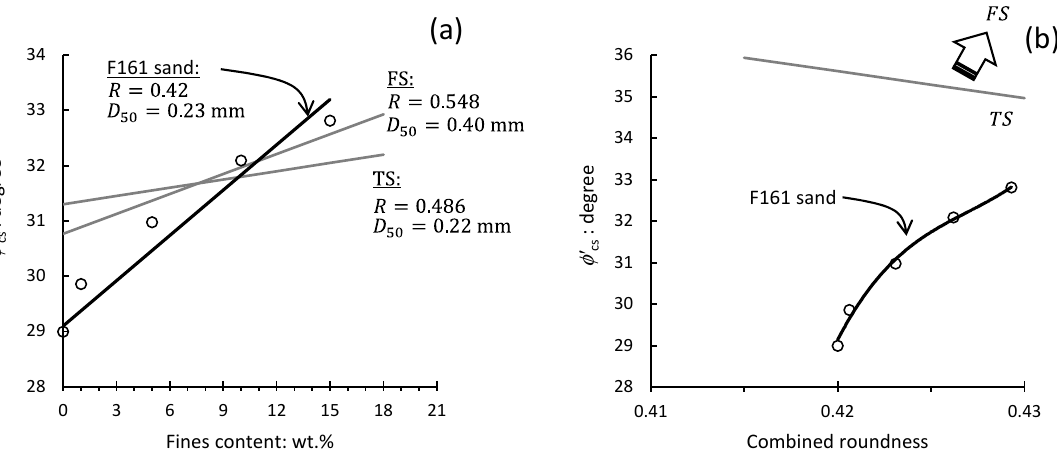
Figure 13. Variation of critical state friction angle with; ( a ) NS content; and ( b ) combined roundness of particles forming binary mixtures. Note: FS and TS, Fujian and Toyoura sands (Yang and Wei, 2012); F161, base sand for present investigation.